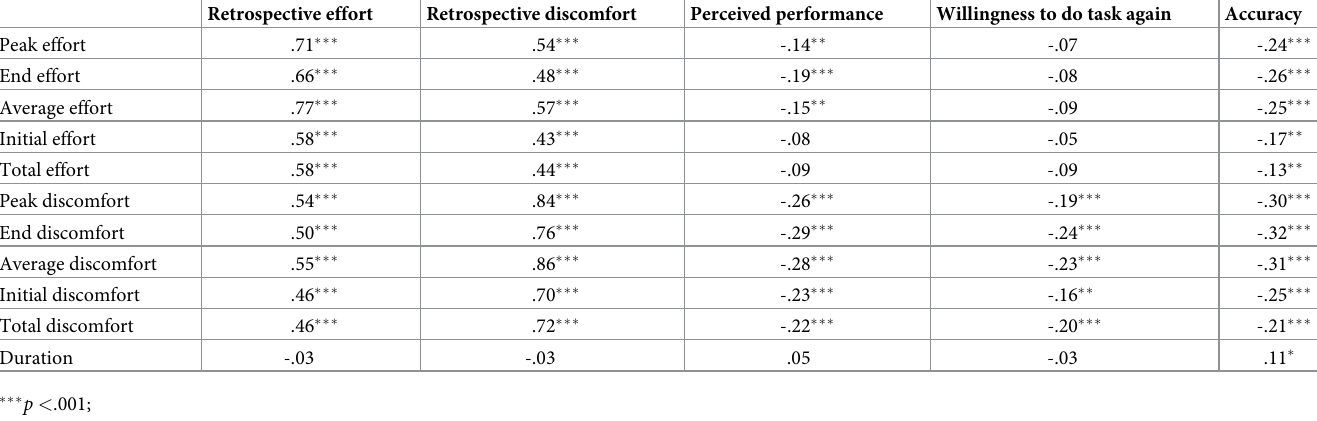
Table 3. Correlations between effort, discomfort, perceived performance, willingness to do task again and accuracy. Retrospective effort